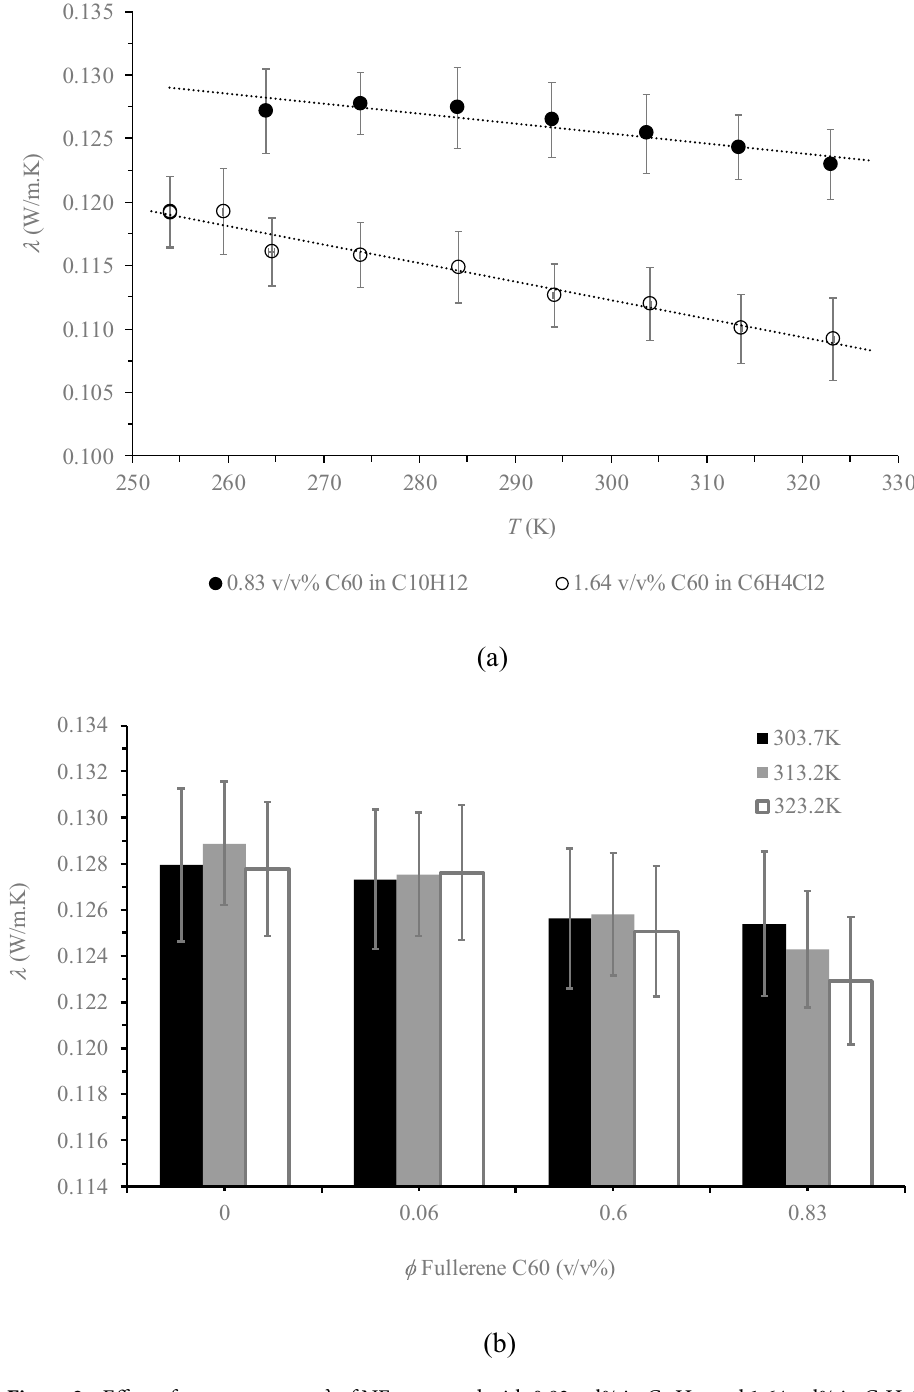
Figure 2. Effect of temperature on λ of NFs prepared with 0.83 vol% in C 10 H 12 and 1.64 vol% in C 6 H 4 Cl 2 ( a ) and effect of C 60 concentration ( ϕ ) on λ of NFs prepared with C 10 H 12 for different temperatures ( T ) ( b ). Microsoft Excel 2016 was used to generate these